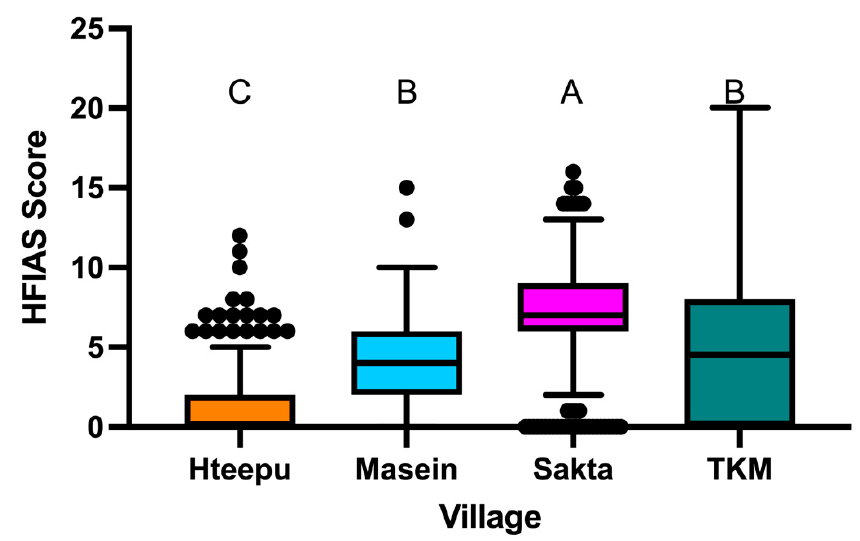
Figure 2. HFIAS Scores recorded from four Myanmar CSVs. The central line of each column represents the mean HFIAS Score for each CSV ± the standard error, with the outermost lines representing standard deviation. One-way ANOVA was used to determine statistical differences; villages with different letters are significantly different at a 95% confidence interval.